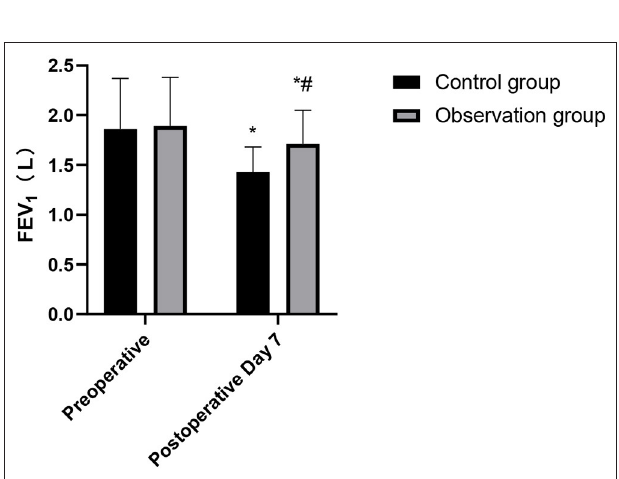
FIGURE 4 | Comparison of FEV 1 changes in the patients of the two groups. Compared with preoperative, * p < 0.05. Compared with the control group, # p <